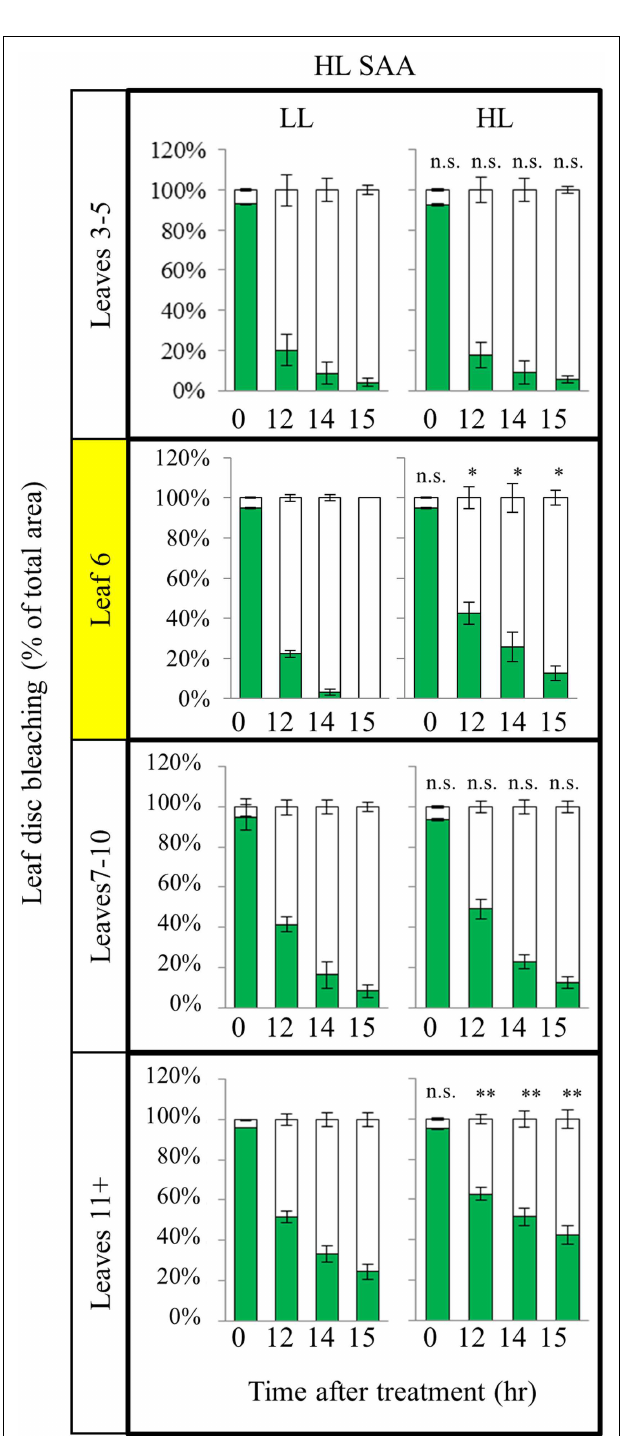
FIGURE 7 | In vitro photo-oxidative stress tolerance assay of repeated, transient HL SAA. Arabidopsis plants were either HL SAA treated for